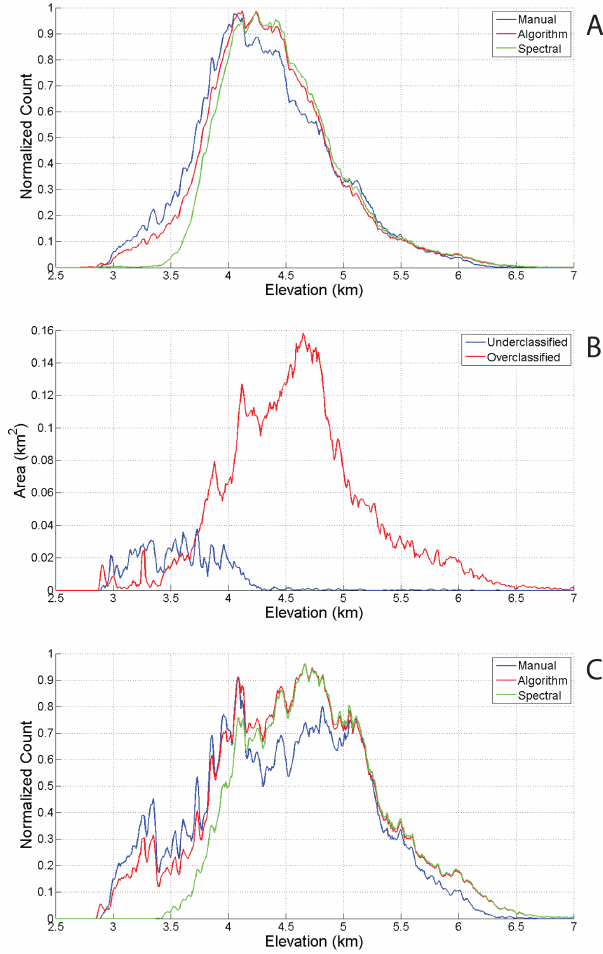
Figure 5. (a) Bulk elevation distributions of sampled glaciers, with manual delineation (reference data set, n = 215, 4500km 2 ) in blue, algorithm-derived delineation in red, spectral delineation in green, and CGI v2 in black. Values have been normalized to maximum probability. (b) Elevation distributions of over- and underclassi- fied glacier areas, as compared to a manual control data set ( n = 75, 330km 2 ); 5.5% is overclassified, and 0.8% is underclassified. (c) Averaged elevation differences for a random sample of glaciers overlapping a manual control data set ( n = 100, 100km 2